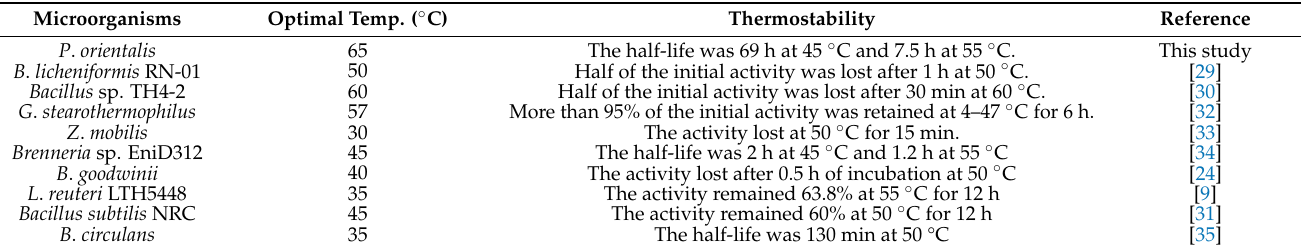
Figure 5. T m and thermostability of recombinant LS. ( A ) T m of Psor-LS. ( B ) Thermostability of Psor-LS at 45 and 55 ◦ C. ( C ) The t 1/2 value of Psor-LS at 45 and 55 ◦ C. Except for the LS from L. reuteri LTH5448, most LSs showed low thermostability at temperatures above 50 ◦ C (Table 1). For instance, the B . licheniformis RN-01 LS retained less than 50% of its initial activity after 1 h of incubation at 50 ◦ C [29]. The LS from Bacillus sp. TH4-2 lost 50% of its initial activity at 60 ◦ C for 30 min [30]. The LS from B . subtilis NRC could retain 60% of its activity after incubating at 50 ◦ C for 2 h [31]. Before this study, the LS from Geobacillus stearothermophilus was reported as the most thermostable LS since it could retain more than 95% of initial activity at 4-47 ◦ C for 6 h [32]. However, the enzyme would rapidly lose activity at higher temperatures (57 ◦ C). Table 1. Thermostability of LSs from different microorganisms.